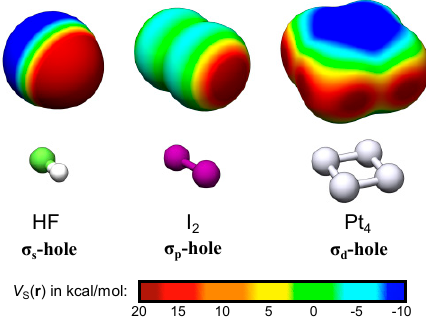
Figure 1. The σ s -, σ p - and σ d -holes are exemplified by the electrostatic potential profiles, V S ( r ), of HF, I 2 and Pt 4 . The V S ( r ) was evaluated on the 0.001 a.u. isodensity contour at structures characterized at the PBE0/def2-TZVPP//def2-SV(P) level of theory [11,12] using the Turbomole 6.4 package [13]. Note that the V S,max of Pt 4 are not located at the corners but at the extension of the bonds (dark red areas).